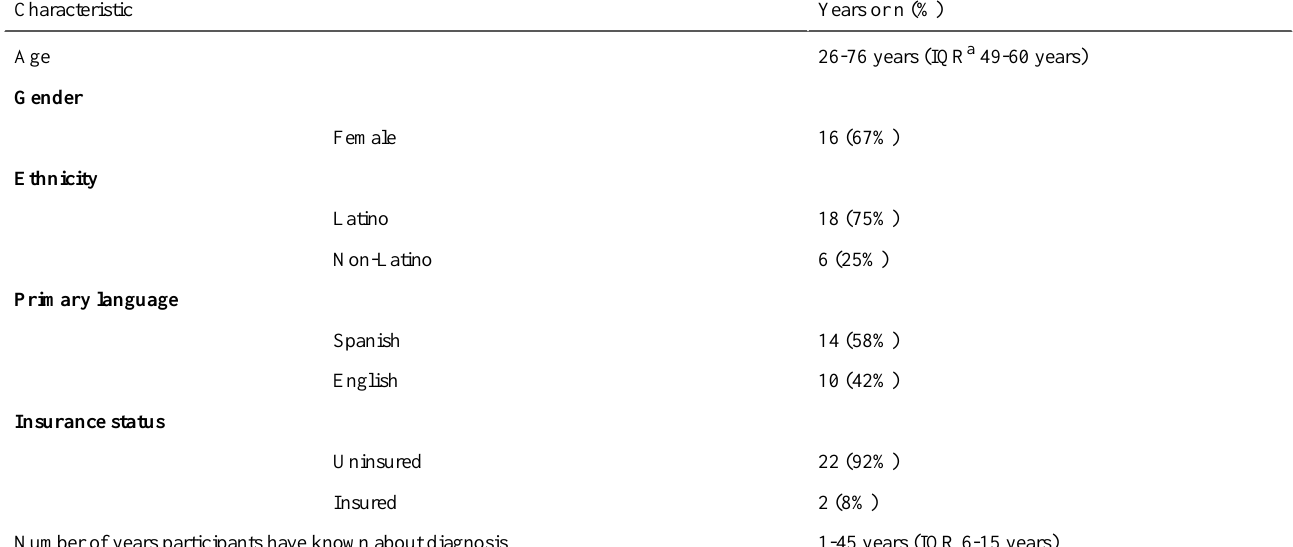
Table 1. Focus group participant characteristics (n=24).